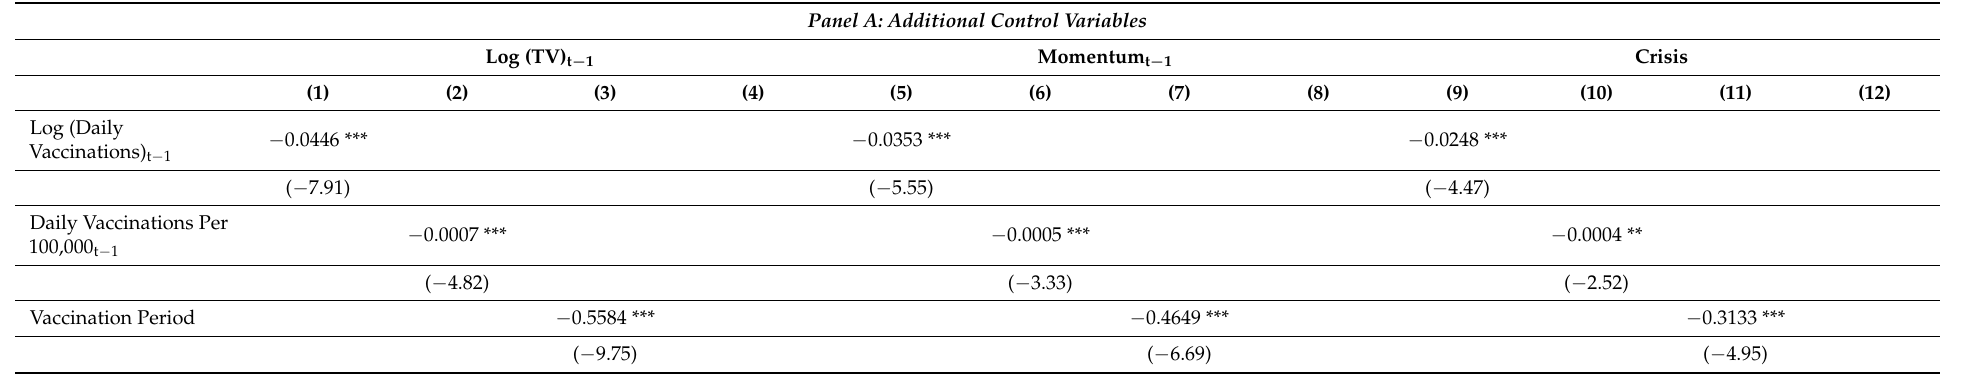
Table 6. Robustness checks—further control variables and modified study period. Panel A: Additional Control